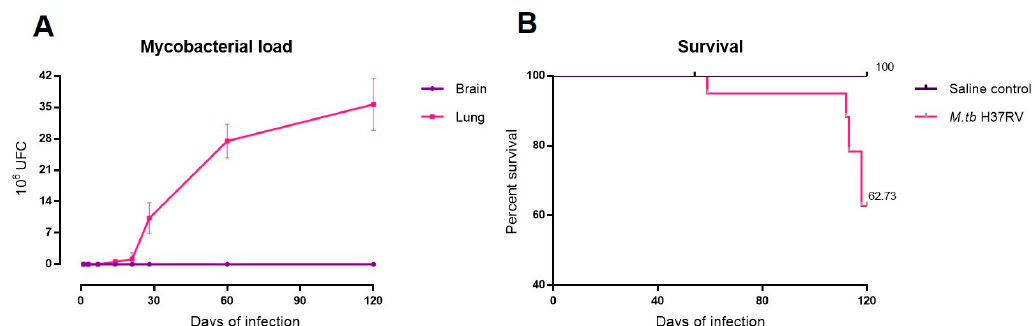
Figure 1. Mycobacterial loads in brain and lung and survival rate of BALB / c mice infected with 2.5 × 10 5 colony-forming unit (CFU) of M. tb H37Rv. ( A ) Comparative quantification of CFU from lungs and brains of infected mice at each time of infection ( n = 12). No bacilli loads were detected in the brain homogenates from mice infected with the H37Rv strain. ( B ) Survival rates of mice injected with saline solution (control) or infected with M. tb H37Rv ( M. tb H37Rv) ( n = 36). After two months of infection, infected mice started to